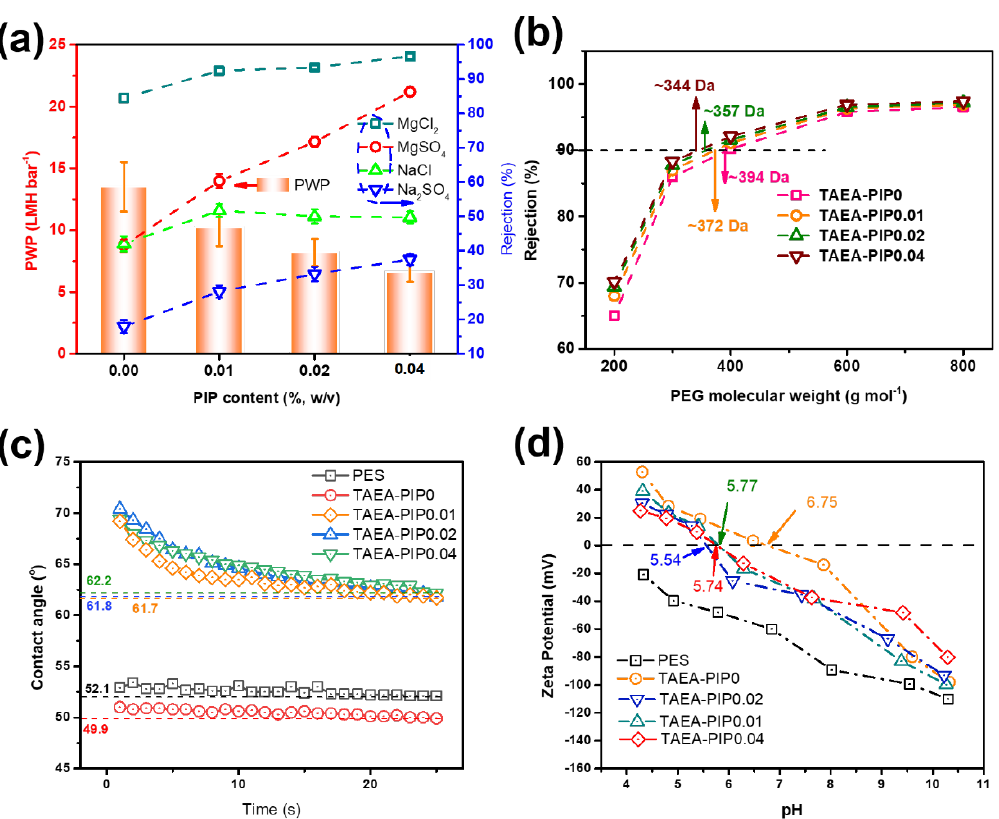
Figure 4. ( a ) Water permeance and salt rejection of membranes with different concentrations of PIP monomer; ( b ) Zeta potential and ( c ) dynamic water contact angles of PES, TAEA-PIP0, TAEA-PIP0.01, TAEA-PIP0.02, and TAEA-PIP0.04 membranes; ( d ) MWCOs of TAEA, TAEA-PIP0.01, TAEA-PIP0.02, and TAEA-PIP0.04 membranes tested with 200 mg L − 1 PEG aqueous solution at 4 bar.